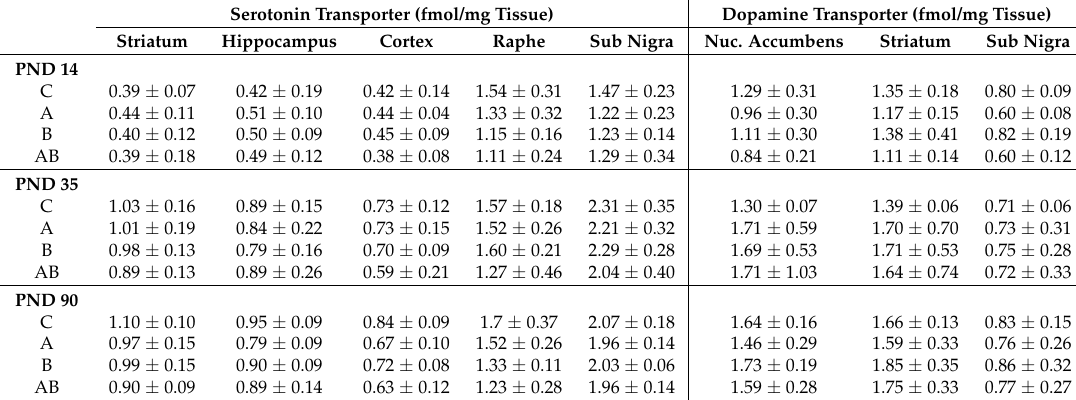
Table 3. Regional SERT and DAT